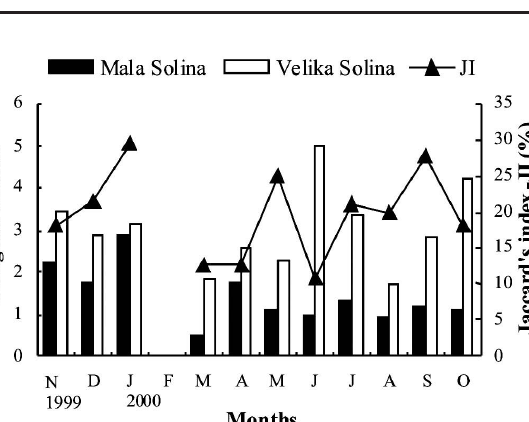
. . . . . . . . . . . 2 . . . . . Oscillatoria sp . . 3 . . . . . . . . . . . . 3 . . . . . . . Unidentified cyanobacteria >20 µm . . . . . . . . . . . . . 4 . . . . . . . . Unidentified spherical cells >20 μm . . . . 2 2 4 . 3 . 3 2 . 2 . . . 2 . . . 1